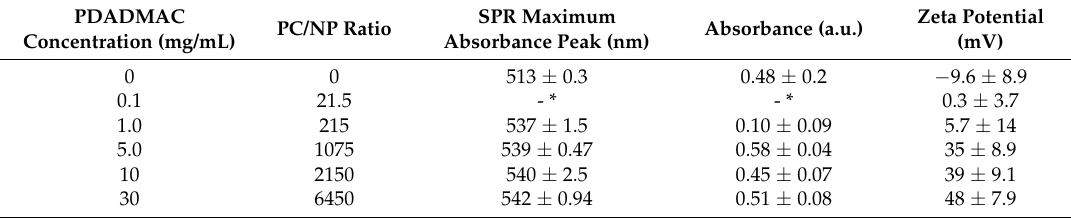
Table 1. Concentrations of PDADMAC showing polyelectrolyte chains to nanoparticles (PC/NP) ratio, compared to their average surface plasmon resonance (SPR) peak position and zeta potentials at pH 6.0 ±